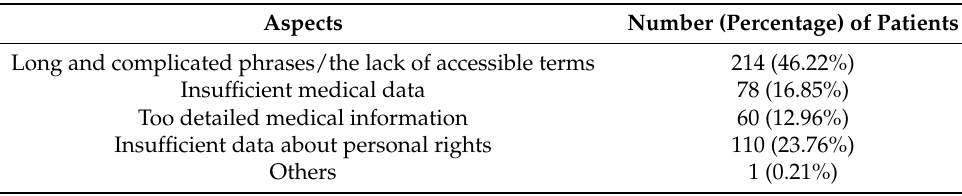
Table 5. The useless aspects that the physician could expose in the study presentation.